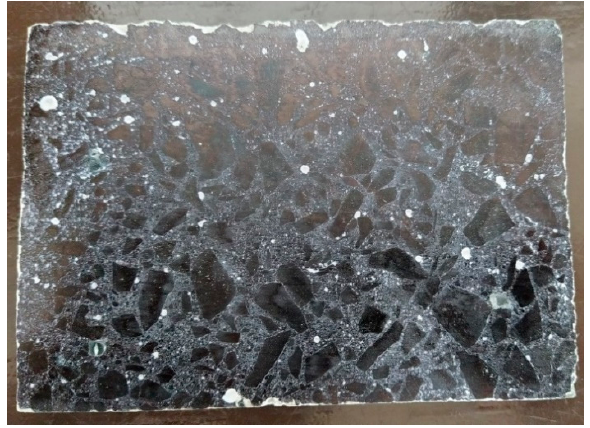
Figure 3. Concrete sample prepared for air pore distribution tests.